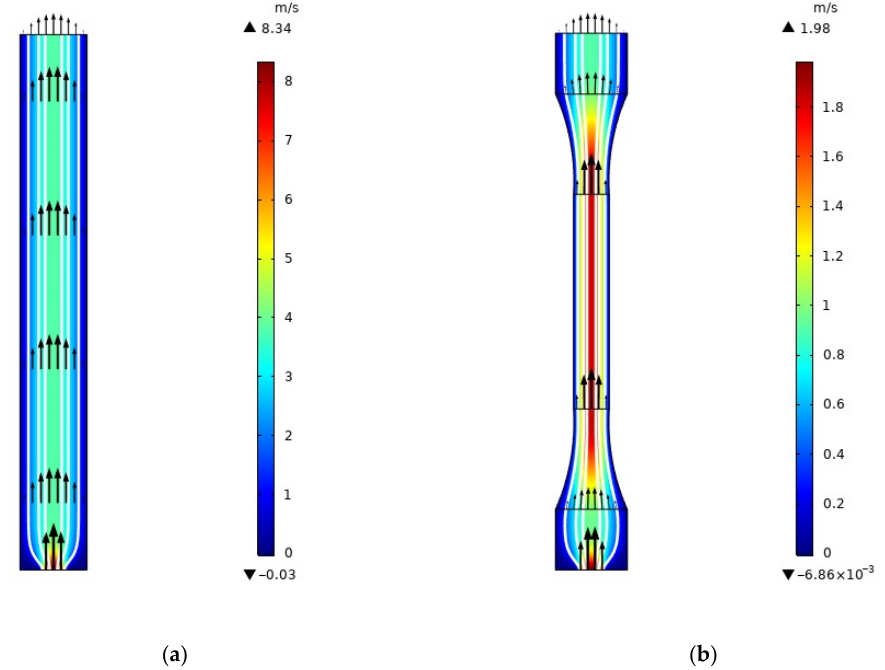
Figure 10. The vertical component of the velocity field (i.e., v) and velocity profiles for ( a ) rectangular and ( b ) dog bone samples. The white lines represent velocity streamlines. and ( b ) dog bone samples. The white lines represent velocity